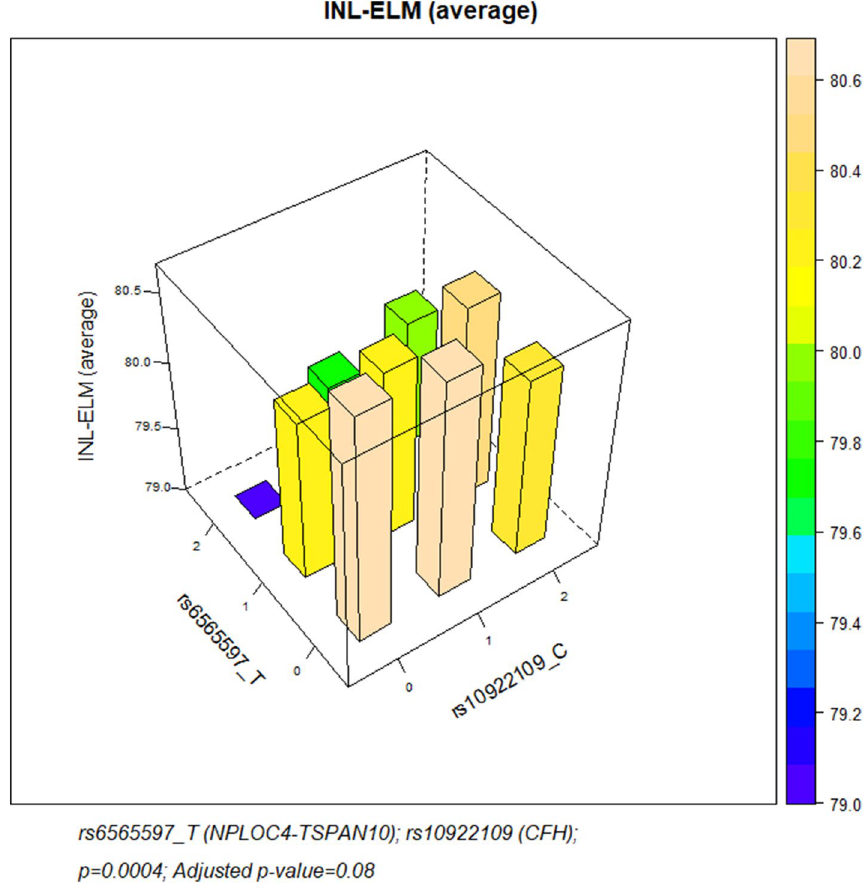
Figure 3. Association of the INL-ELM thickness with two common AMD-associated genetic polymorphisms (rs10922109 and rs6565597). The dosage of the AMD-predisposing alleles at these SNP loci (C and T respectively) is shown in the x- and y-axes. Values of 0, 1 and 2 denote number of the AMD risk alleles present in individual genotypes (i.e. risk allele is not present, heterozygous or homozygous genotypes for that